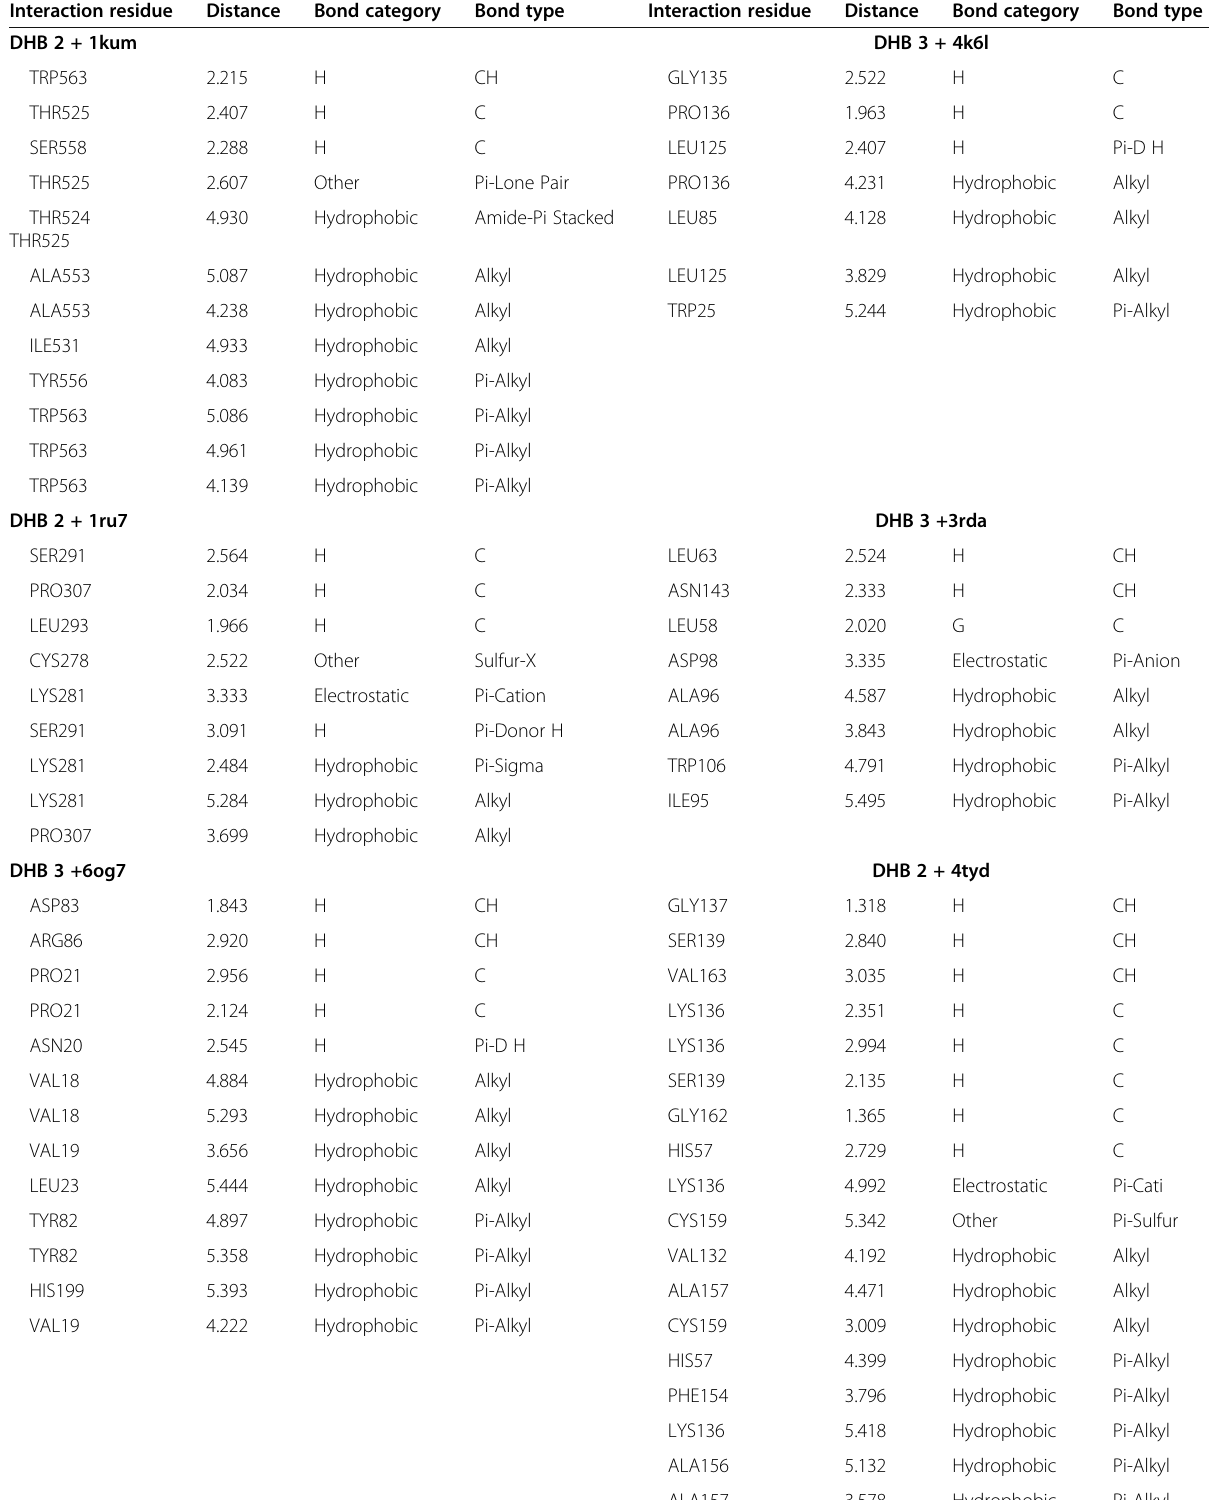
Table 4 Nonbonding interactions of selected two DHB with six proteins (pose predicted by FireDock). CH conventional hydrogen bond, H hydrogen bond, C carbon hydrogen